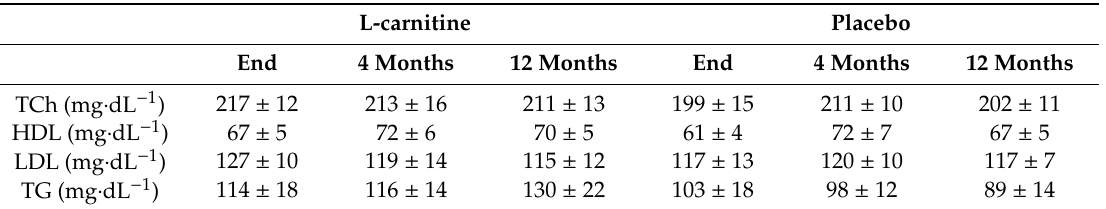
TCh: total cholesterol; HDL: high-density lipoprotein cholesterol; LDL: low-density lipoprotein cholesterol; TG: triglycerides.